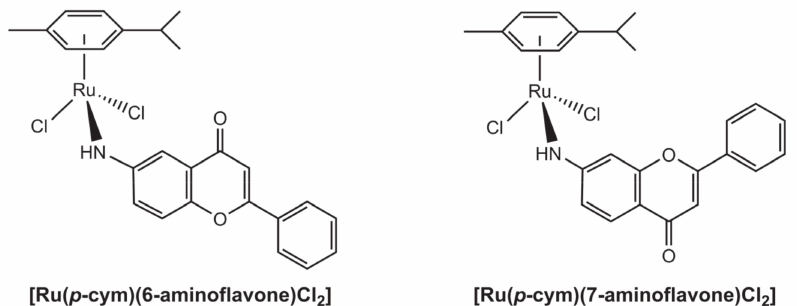
Figure 9. Structural representation of two ruthenium p -cymene complexes bearing aminoflavone